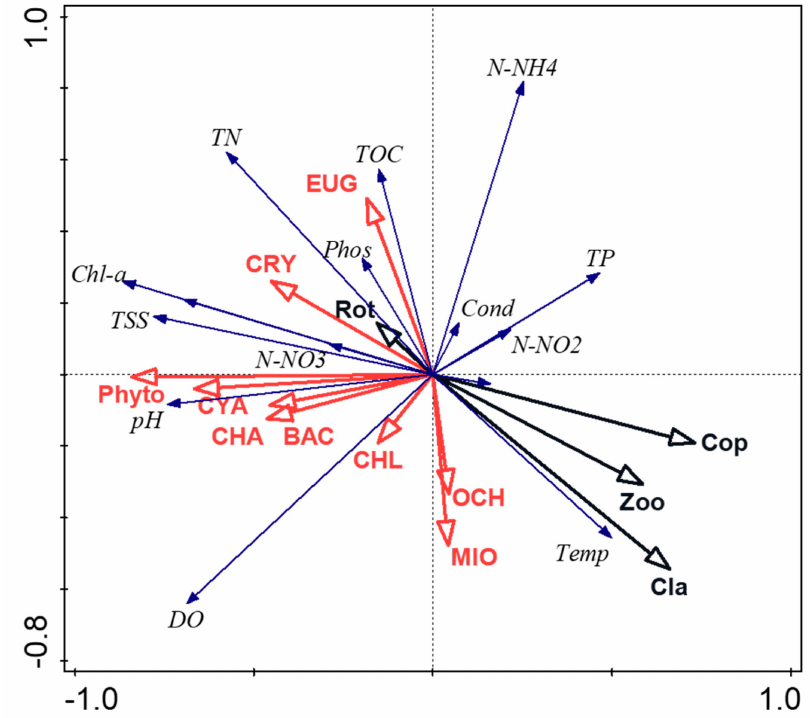
Figure 6. The redundancy analysis (RDA) relative to phytoplankton, zooplankton, and environ-